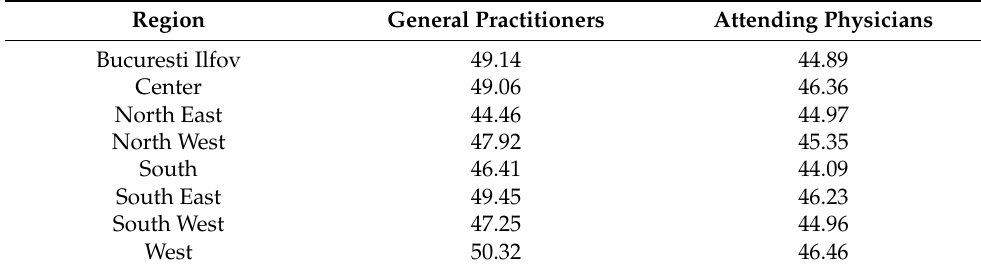
Table 1. Physicians’ legal compliance within regions and specialties (%). Region General Practitioners Attending